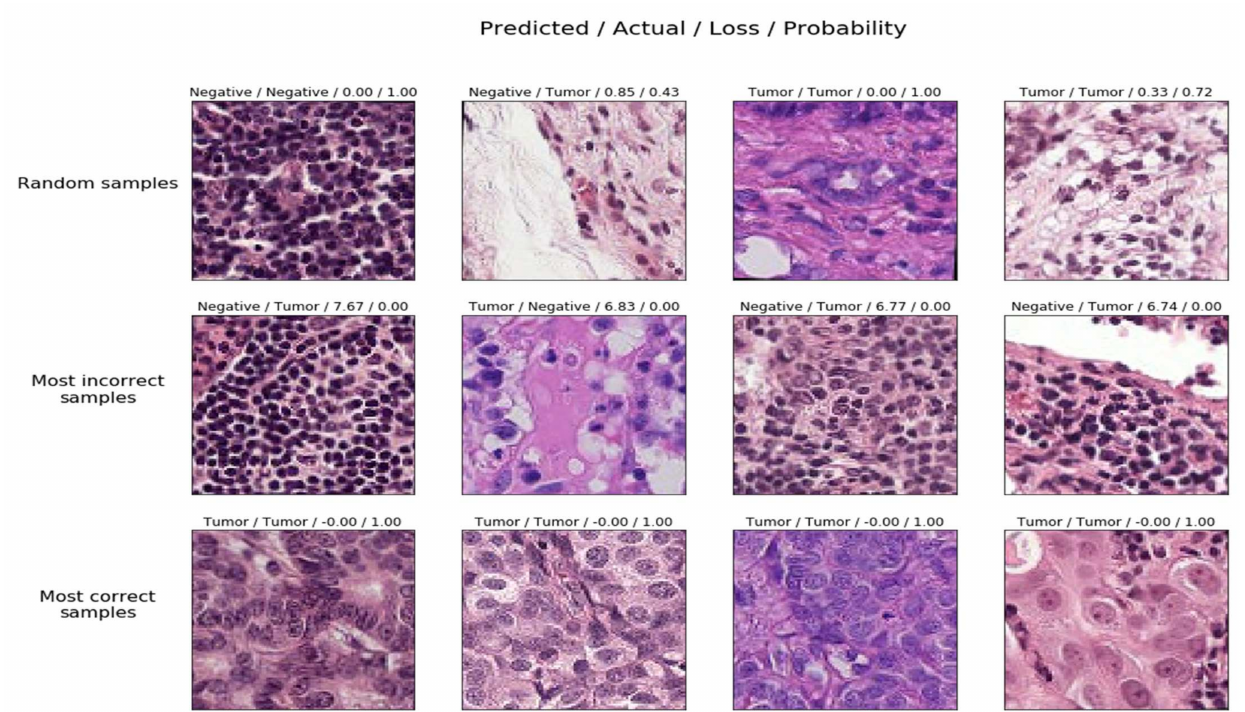
Figure 13. Probabilities scores associated with samples in the testing phase.